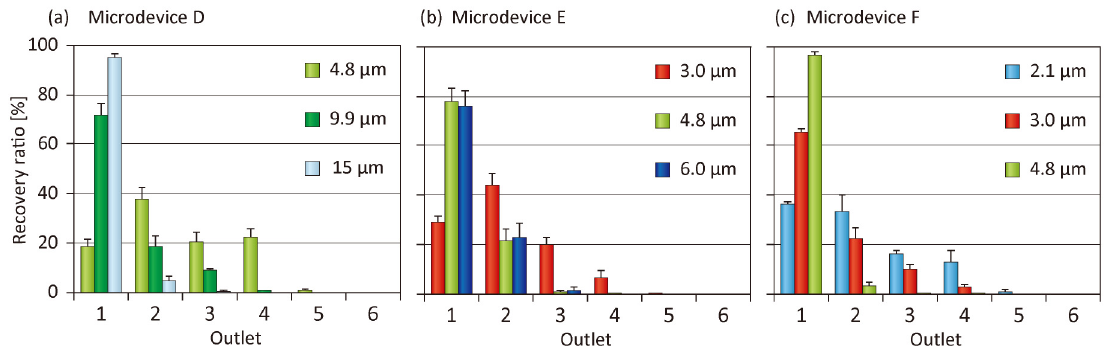
Figure 7. Separation results of model particles with different similitude ratios; ( a ) similitude ratio was 1.5 (microdevice D), ( b ) similitude ratio was 0.66 (microdevice E), and ( c ) similitude ratio was 0.5 (microdevice F). The Q total and Q 1 :Q 2 :Q 3 were 120 µ L / min and 1:1:4, respectively. Each dataset presents the mean ± SD from three individual demonstrations.